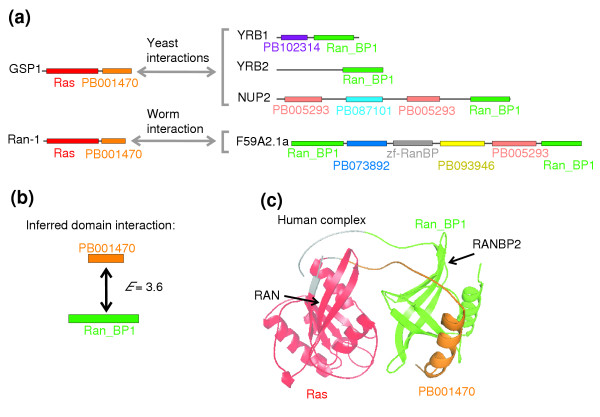
Domain interactions of Ras family members with nuclear pore proteins. (a) Yeast and worm Ran signal-transducing proteins interact with proteins that have Ran-binding domains [Pfam:PF00638, Ran_BP1], often found as components of nuclear pore complexes. Domain structures of the relevant interacting proteins are shown. Domains of proteins are colored boxes connected by a gray line. Protein names are in black to the left of each protein's domain structure schematic. Pfam-A domain names and Pfam-B accession numbers are the same color as the domains they label. Domain structures are schematic and are not to scale. (b) We find evidence for the interaction of a Pfam-B domain [Pfam:PB001470] the Ran_BP1 domain (E = 3.7). (c) Structural evidence [PDB:1RRP] [43] confirms that the domains PB001470 and Ran_BP1 interact, consistent with our prediction.